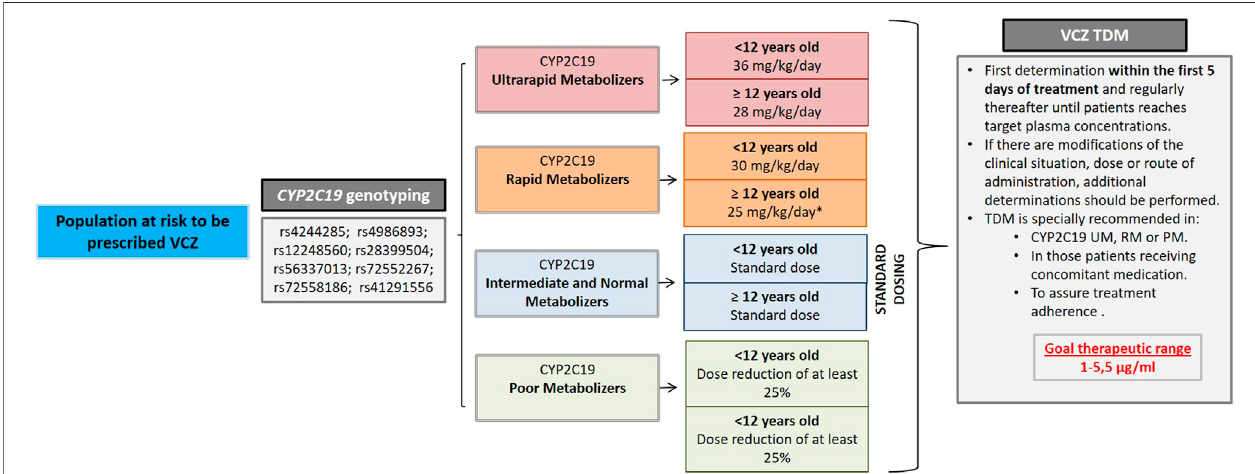
FIGURE 1 | Strategy implemented in La Paz University Hospital (HULP) for the individualization of VCZ therapy in 2017. Dose adjustments based on PGx informationwerederivedfromHicksetal. ’ sstudy(Hicksetal.,2014)andCPICguidelinesforCYP2C19andVCZtherapy(Moriyamaetal.,2017)exceptdoseadjustment forRapidMetabolizer(RM)patients ≥ 12yearsold(*),whichwerebasedonliterature,andobservationsmadeinourhospitalHicksetal.(2014)proposedstandarddosing forthesepatients.ForpoorMetabolizers,strictcontrolsevery24 harerecommended,astheriskoftoxicityiselevated. IfADRsaredetected,chooseanalternative agent. TDM recommendations were based on TDM guidelines of the British Society for Medical Mycology (Ashbee et al., 2014).